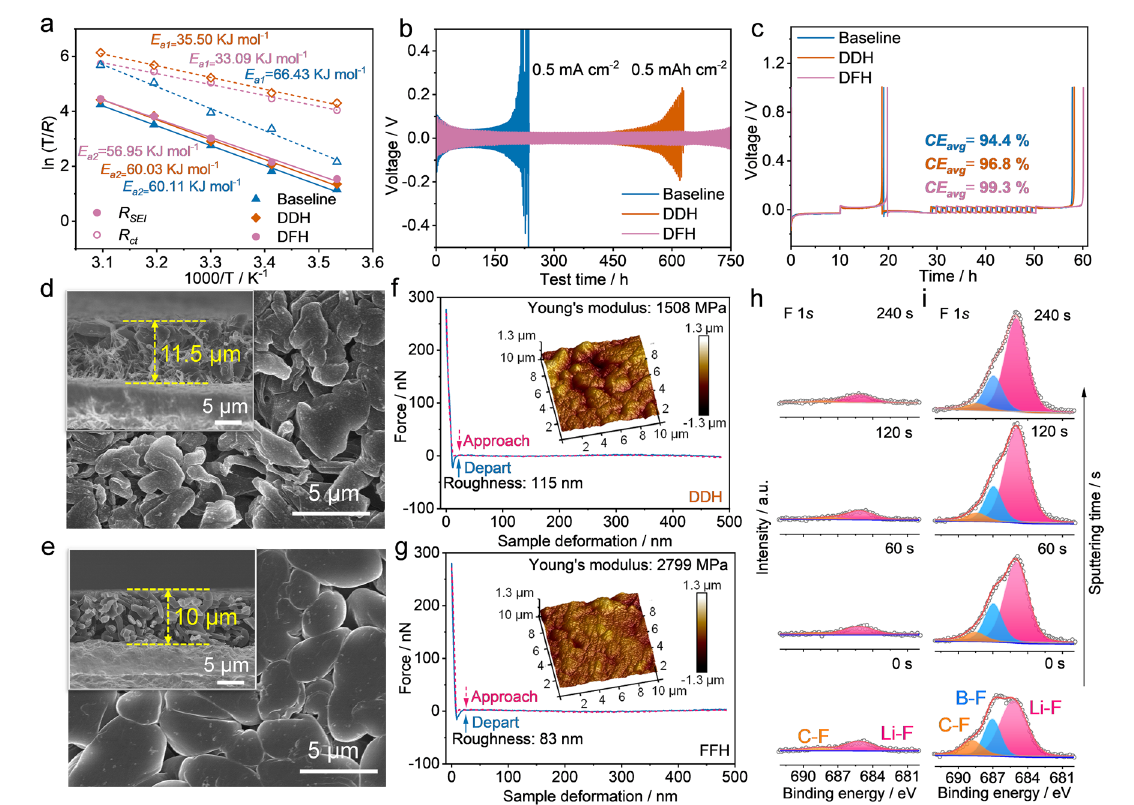
Fig. 3 Li plating/stripping behavior and interfacial characterization. a The activation energies of R SEI and R ct derived from Nyquist plots of cycled Li||Li symmetric cells with baseline, DDH, and DFH electrolytes. b Voltage profiles of Li||Li symmetric cells using baseline, DDH, and DFH electrolytes at 0.5 mA cm −2 with a cutoff capacity of 0.5 mAh cm −2 . c CE avg tests of Li plating-stripping in Li||Cu cells using baseline, DDH, and DFH electrolytes at 0.5 mA cm −2 with capacity of 0.5 mAh cm −2 . Top and cross-sectional (shown in inset) FE-SEM images of the